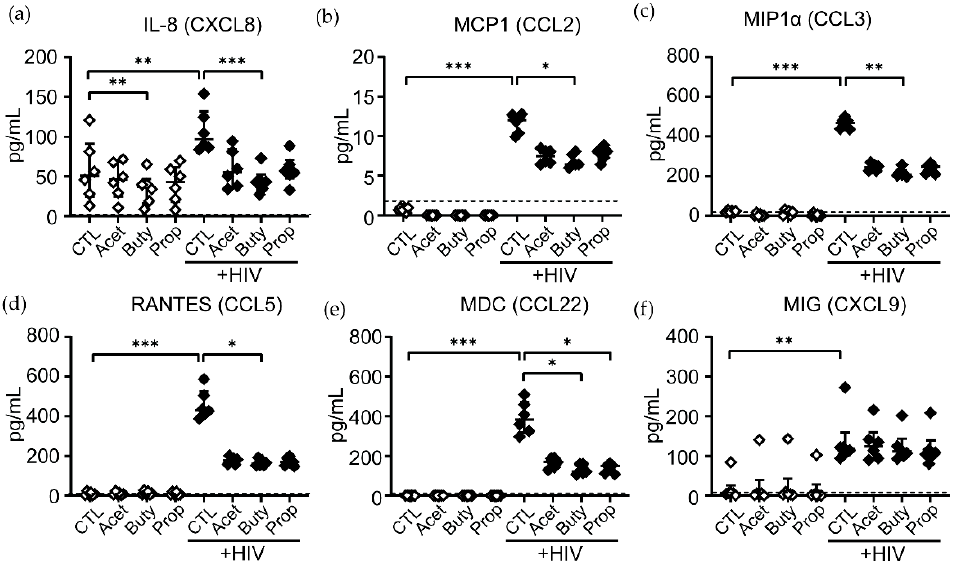
Figure 6. High concentrations of butyrate significantly reduces the release of chemokines in response to HIV stimulation. Neutrophils were stimulated with HIV-BaL in the presence or absence of SFCAs for 1 h, and cell-free supernatants were used to quantify the concentration of the following molecules by Luminex: ( a ) IL-8 (CXCL8), ( b ) MCP-1 (CCL2), ( c ) MIP1 α (CCL3), ( d ) RANTES (CCL5), ( e ) MDC (CCL22) and ( f ) MIG (CXCL9). Each dot represents a different patient ( n = 6). Dotted line: limit of detection. Non-parametric paired Friedmann test was used, * p ≤ 0.05, ** p ≤ 0.01, *** p ≤ 0.001. CTL: control; Acet: acetate 25 mM; Buty: butyrate 25 mM; Prop: propionate 25 mM.